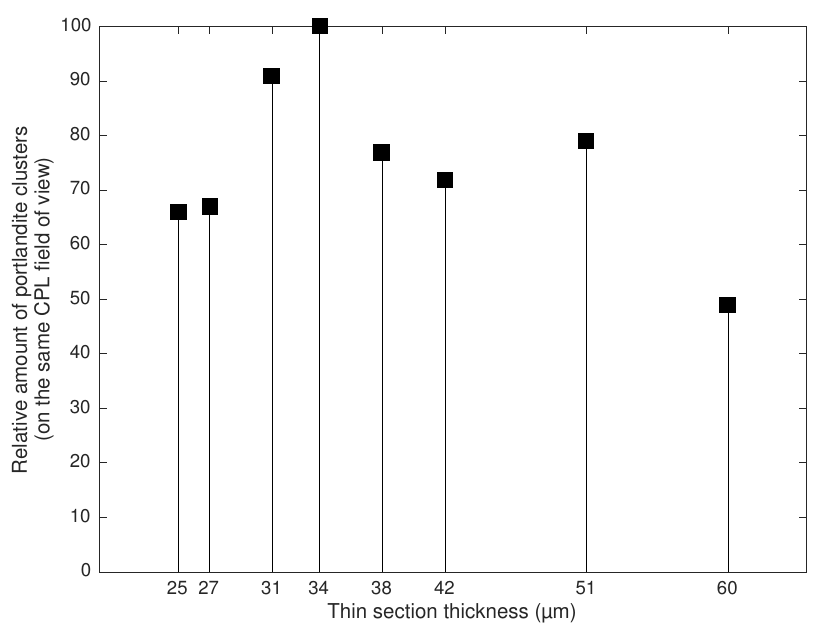
Figure 7. Effect of thin section thickness on the portlandite content estimation. The results are based on point counting and are relative to the 34 µ m section